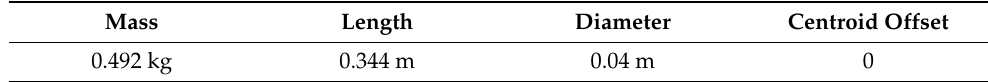
Figure 3. Five head shapes. The hemispherical angles from left to right are 0°, 57°, 70°, 90°, 180°. Table 1. Model parameters.